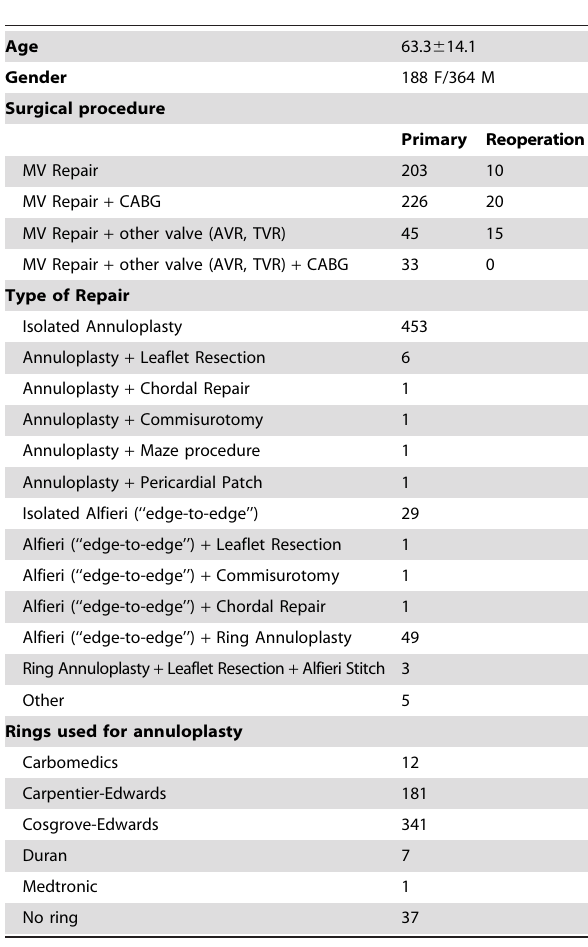
Table 1. Patient Characteristics and Surgical Procedure (N= 552).